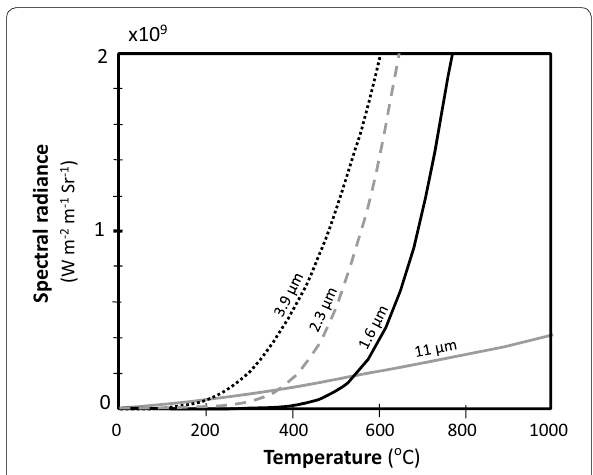
Fig. 3 Relationship between temperature and spectral radiance at different wavelengths based on the Planck